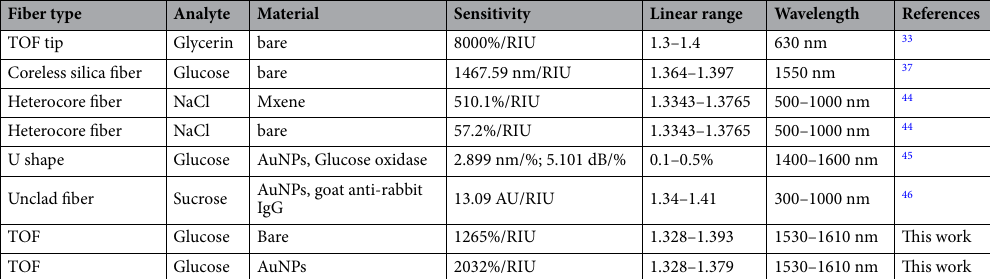
Table 2. Comparison of the analyte characteristic of optical fiber RI